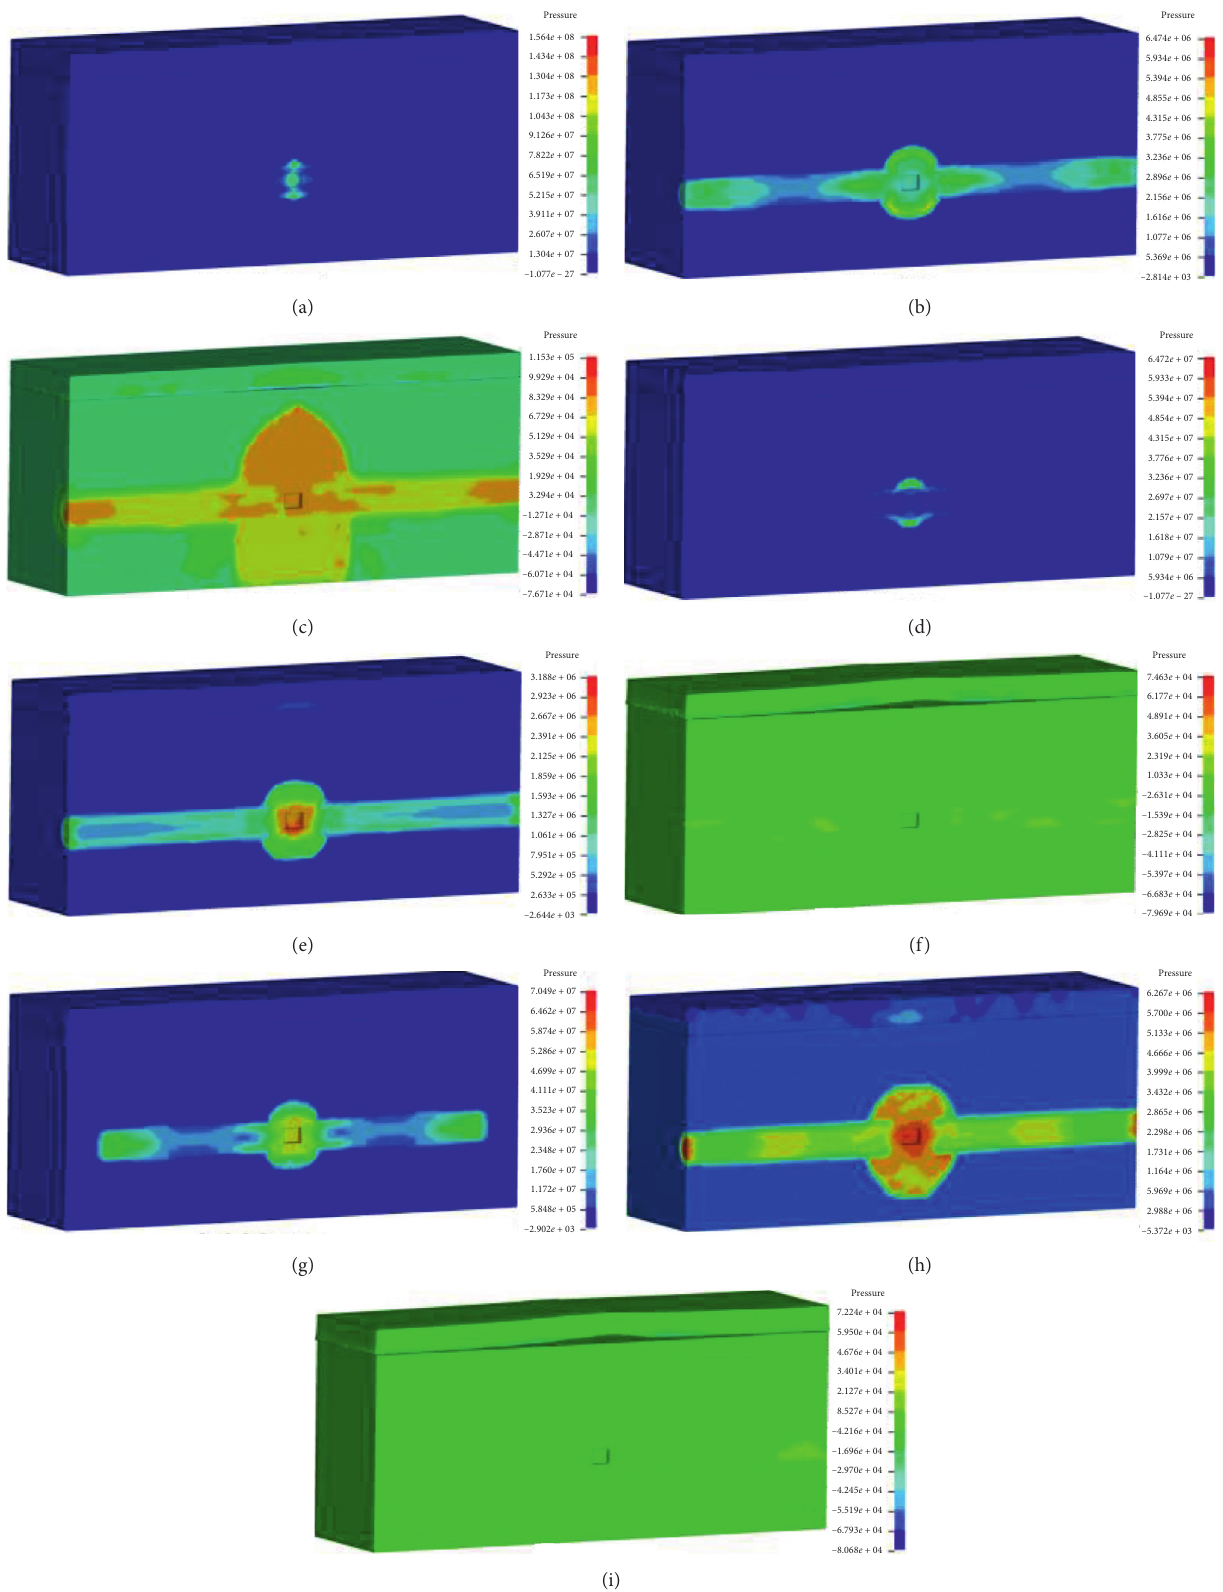
Figure 6: Propagation process of explosive shock waves. (a) 0.099ms. (b) 1.199ms. (c) 16.799ms. (d) 0.199ms. (e) 2.099ms. (f) 44.899ms. (g) 0.999ms. (h) 5.499ms. (i)